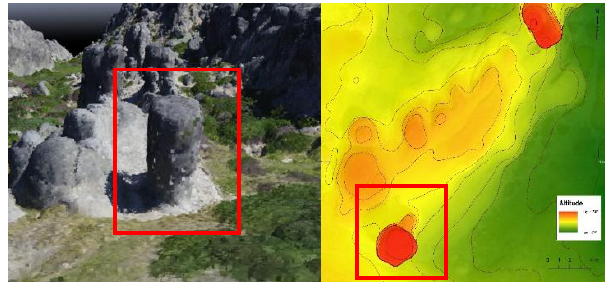
Figure 6. 3D representation of an isolated column - Covão do Boi geosite. In the Covao do boi geosite, differences in the network of trampling areas on the cervunal grass meadow were identified, to the northwest sector, close to the main road.